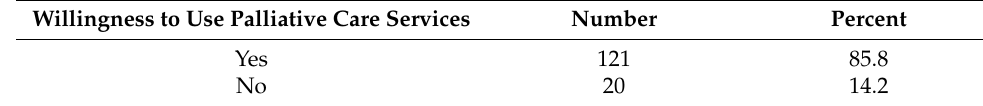
Table 1. Prevalence of willingness to use palliative care services.